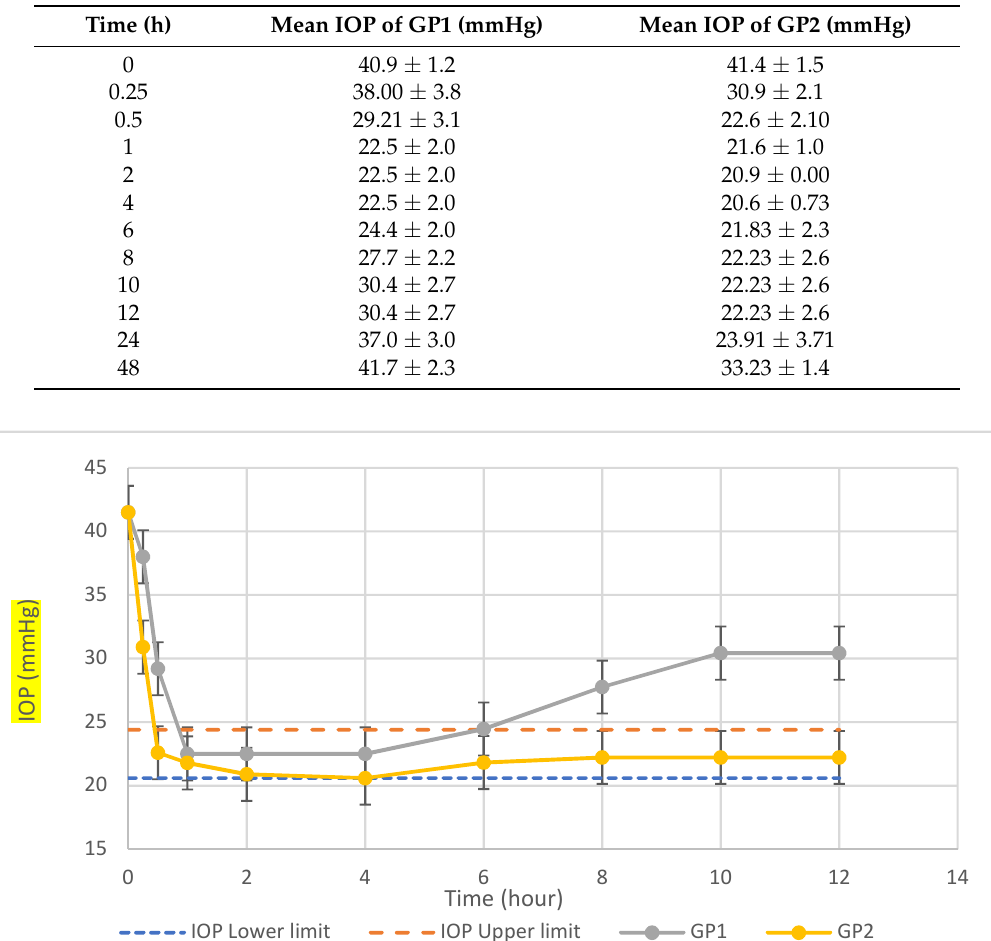
Table 5. Mean intraocular pressure (IOP) value of ocular hypertensive rabbits at different time intervals with different administrations, n = 6.